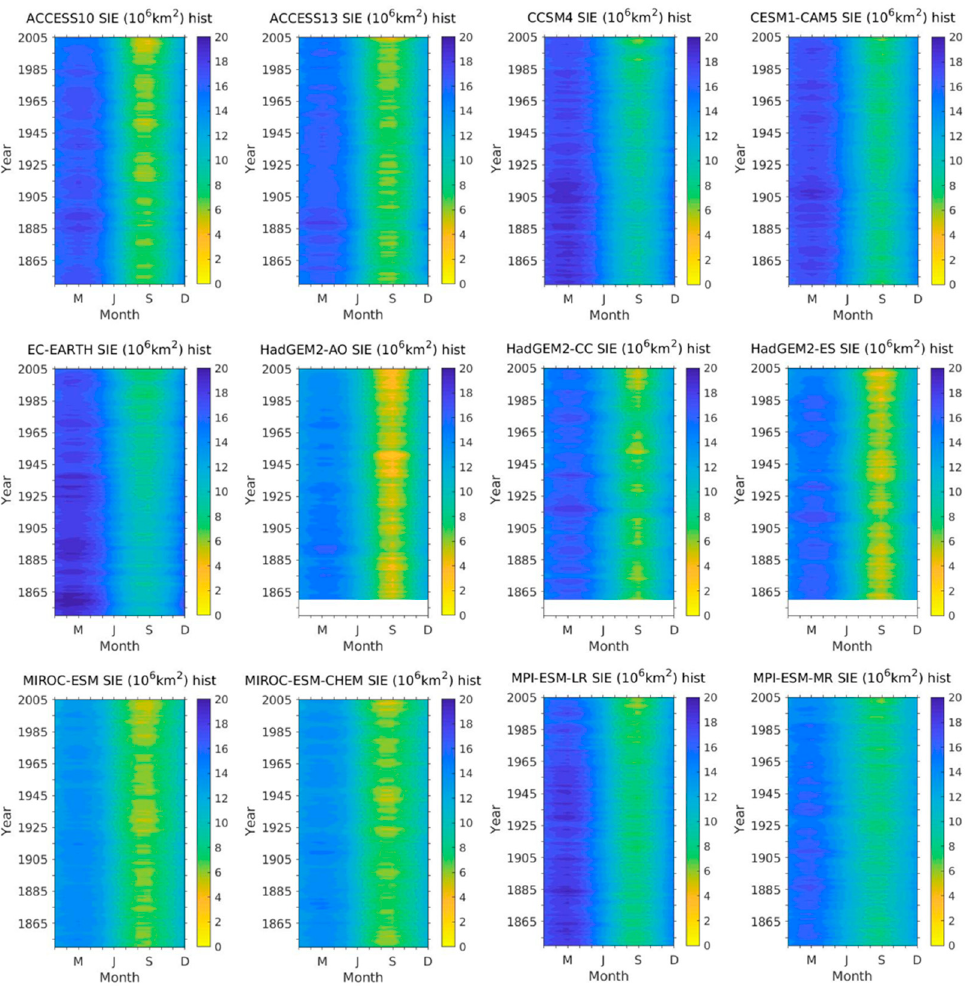
Figure 1. Temporal distributions of simulated historical sea ice extents (SIEs) from 12 Coupled Model Intercomparison Project—Phase 5 (CMIP5) global climate models (see Table 1 for model short names).